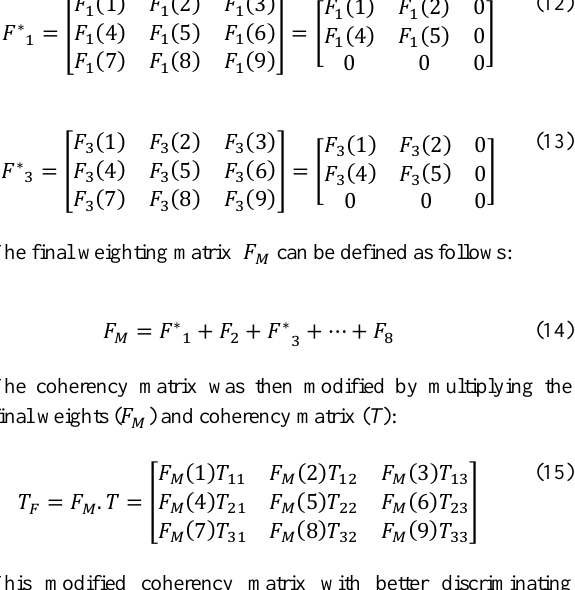
The accuracy assessment was based on confusion matrices generated during each classification procedure. The overall, user and producer accuracy were computed for quantifying the robustness of the proposed method (Table